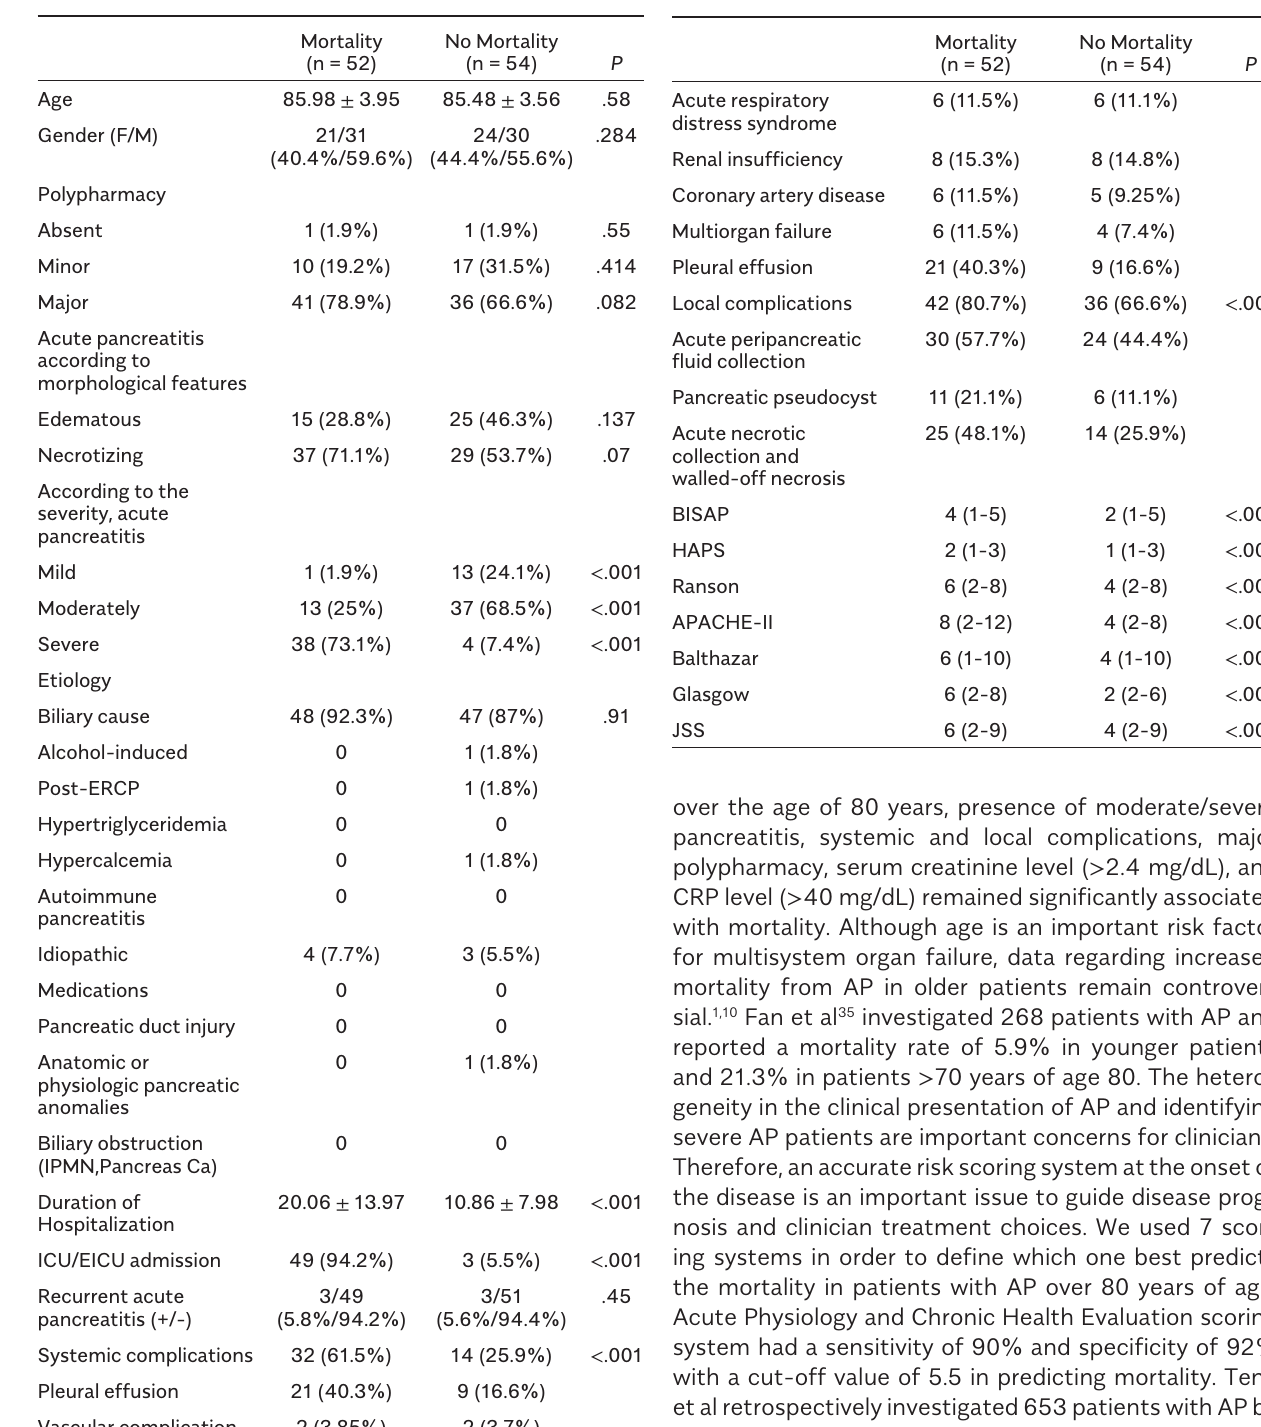
Table 3. Differences Between Patients Aged 80 Years and Older with and Without Mortality ( Continued